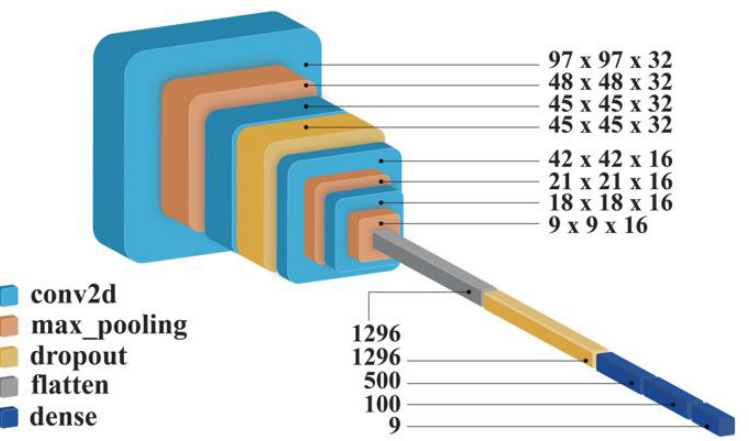
Figure 3. Architecture of the proposed novel convolutional neural network (CNN) model, which includes four convolutional layers, three pooling layers, two dropout layers, and flatten and dense layer.